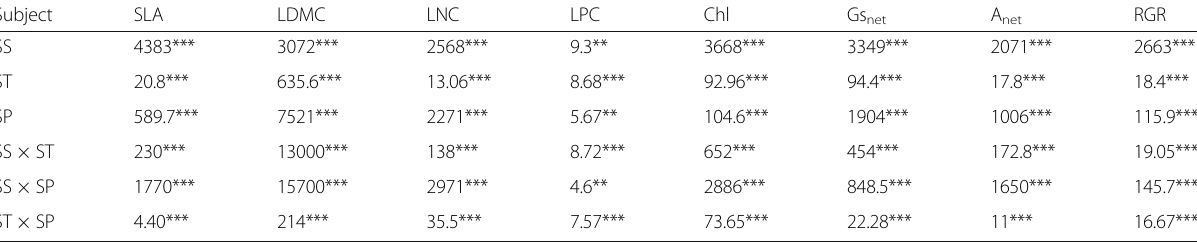
Table 4 Summary of repeated measures ANCOVA, with light (LT 1 ) as covariate, on functional attributes of seedlings of four tropical dry forest tree species (only main effects and two-way interactions are shown) Subject SLA